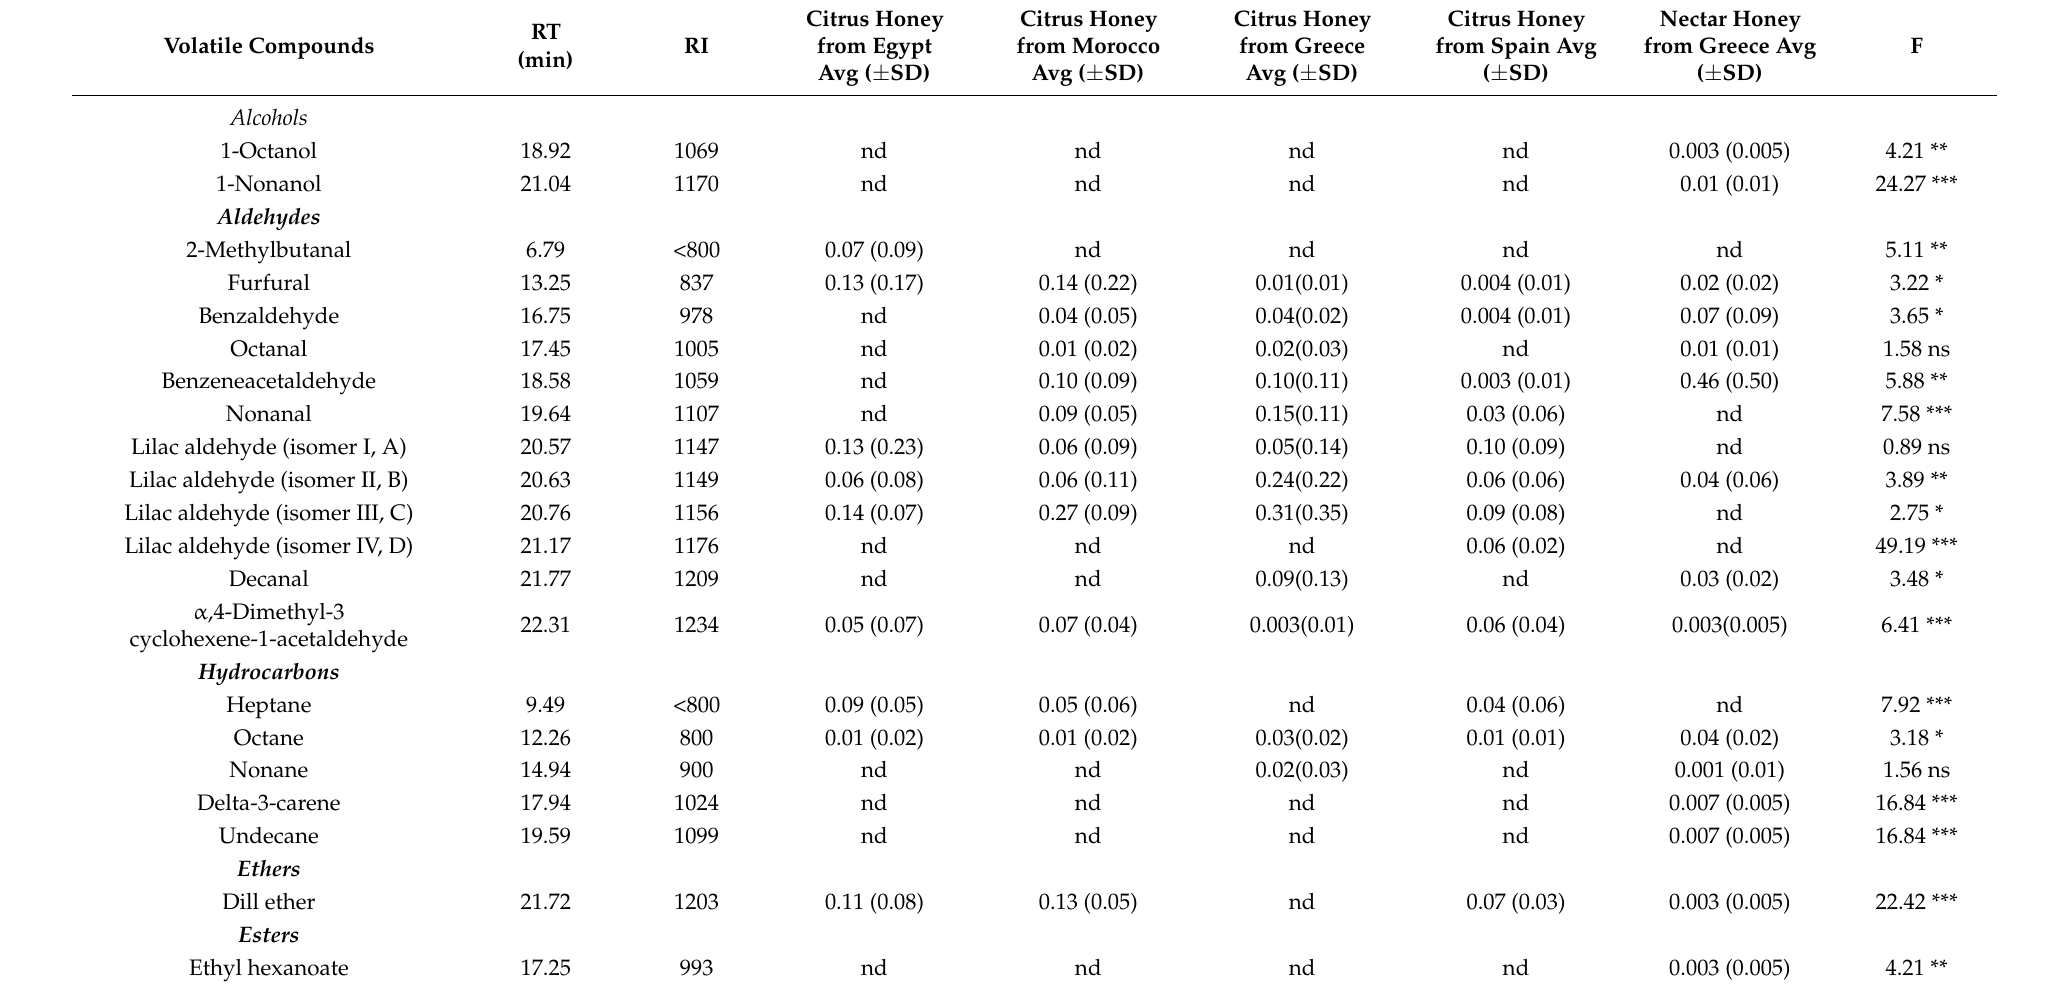
Table 1. Volatile compounds (mg/kg) identified in citrus and nectar honey of different geographical